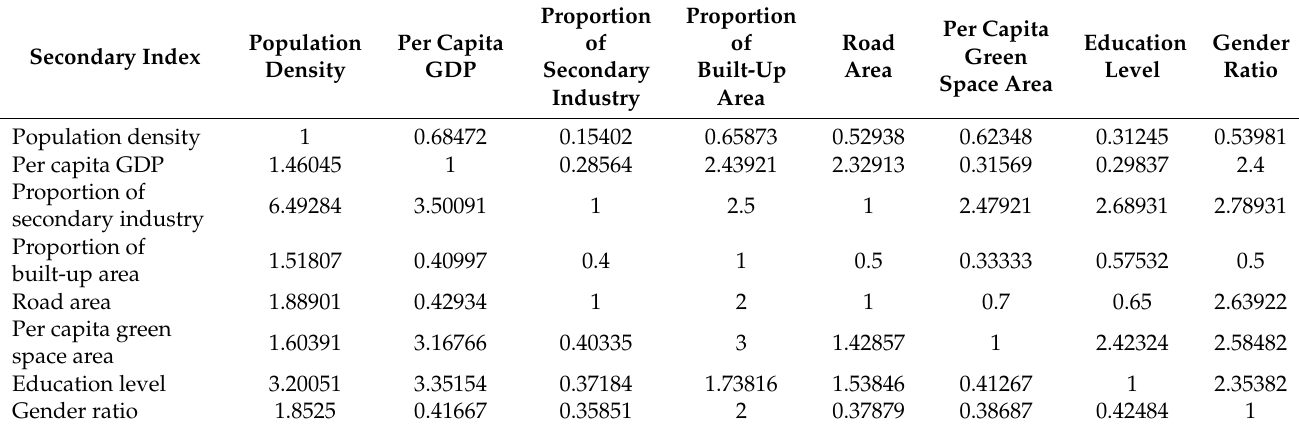
Table 8. Secondary index judgment matrix 2.